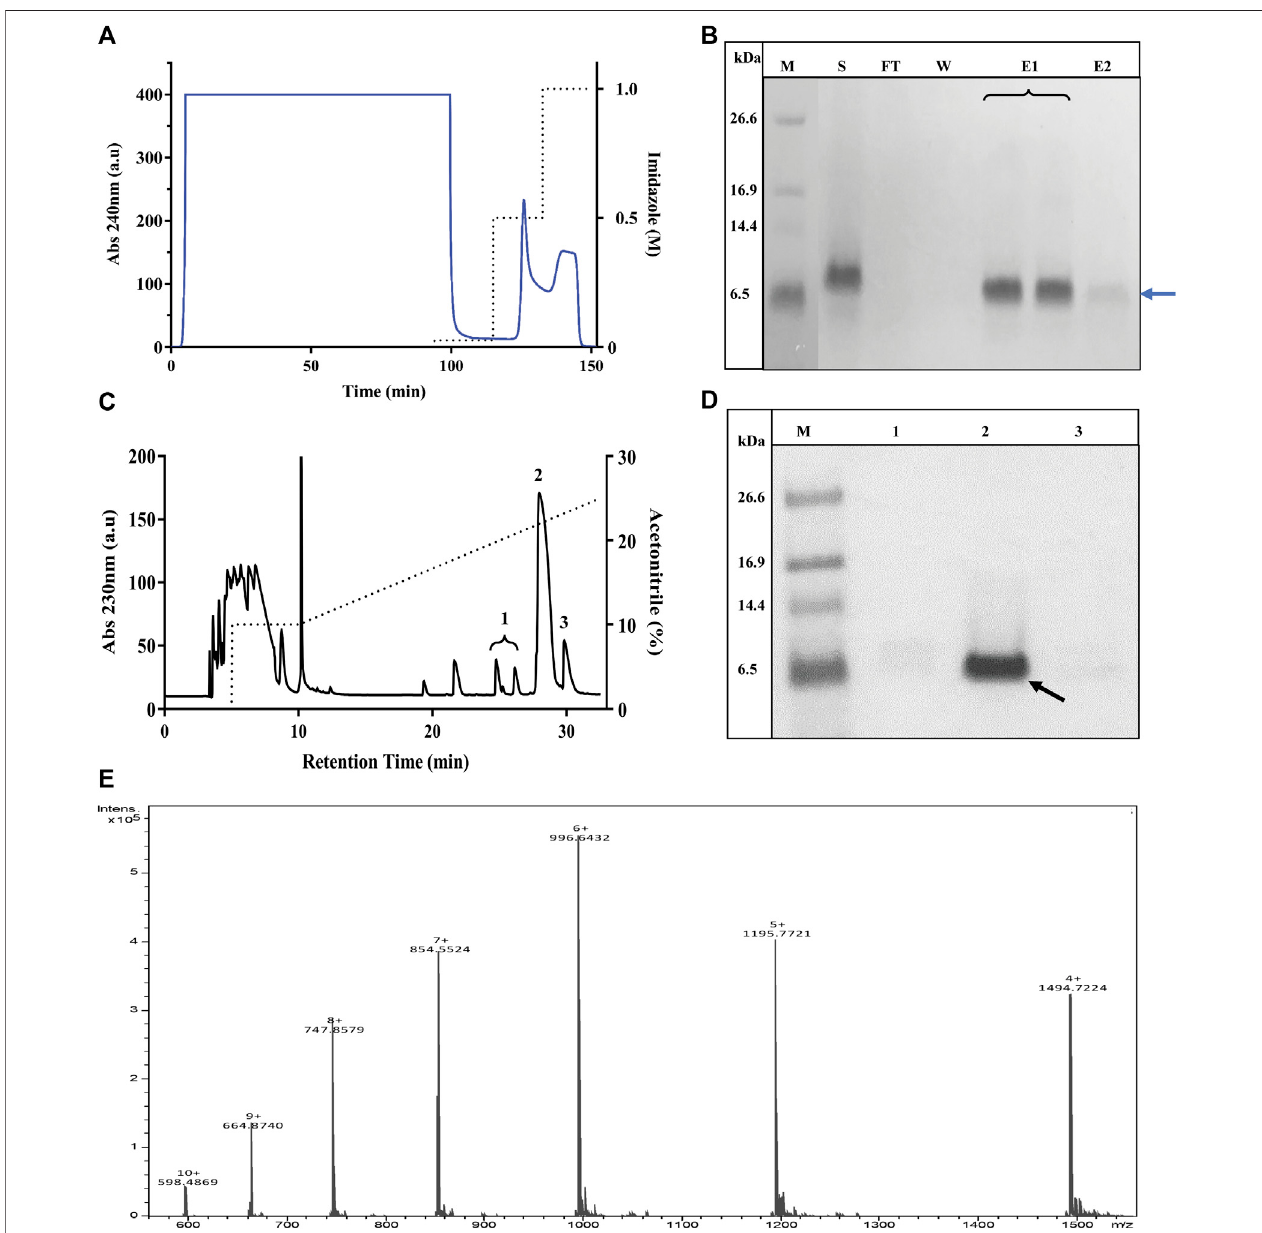
FIGURE 3 | Puri fi cation of TrMgTx. (A) The chromatogram shows the loading of the supernatant of P. pastoris culture (cultured for 72 h, pH 6, induced with 0.5% MeOH) on a Ni 2+ af fi nity column and elution with imidazole in isocratic mode. Absorbance was measured at 240 nm (indicated with blue line, left axis) and dotted line denotes the concentration of imidazole in elution buffer (right axis). (B) 16% Tricine – SDS-PAGE illustrates the analysis of fractions collected from Ni 2+ af fi nity chromatography, where lane labels stand for M : low-molecular-weight (LMW) protein marker, S : raw (unpuri fi ed) supernatant, FT : fl ow through, W : wash with washingbuffer, E1 :elutionwith0.5 Mimidazole,and E2 :elutionwith1 Mimidazole.Abandat6.5 kDaposition(bluearrow)inlaneE1andE2representspartiallypuri fi ed TrMgTx. (C) RP-HPLCchromatogramofTrMgTx. Partially puri fi edTrMgTx instep1 (A,B) wasapplied onRP-HPLCC 18 semi-prep columnand elutedwithagradientof 10 – 30% acetonitrile (shown with dotted line, right axis) over 30 min. Absorbance was recorded at 230 nm (left axis). Numbers indicate the peaks collected. (D) 16% Tricine – SDS-PAGE analysis of fractions collected from the RP-HPLC column. Lanes represent M : LMW protein marker, 1 – 3 : fractions from corresponding peaks as indicated in RP-HPLC chromatogram (panel C ). The band of 6.5 kDa in lane 2 indicated with a black arrow represents puri fi ed TrMgTx. (E) ESI-QTOF-MS spectrum shows the average mass (5980.86 Da) of puri fi ed TrMgTx.